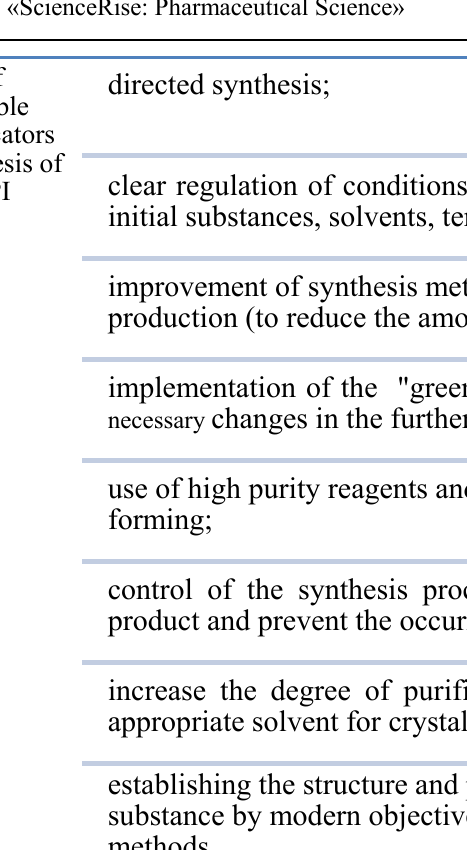
Fig. 3. Basic principles for ensuring stable quality indicators in the synthesis of potential